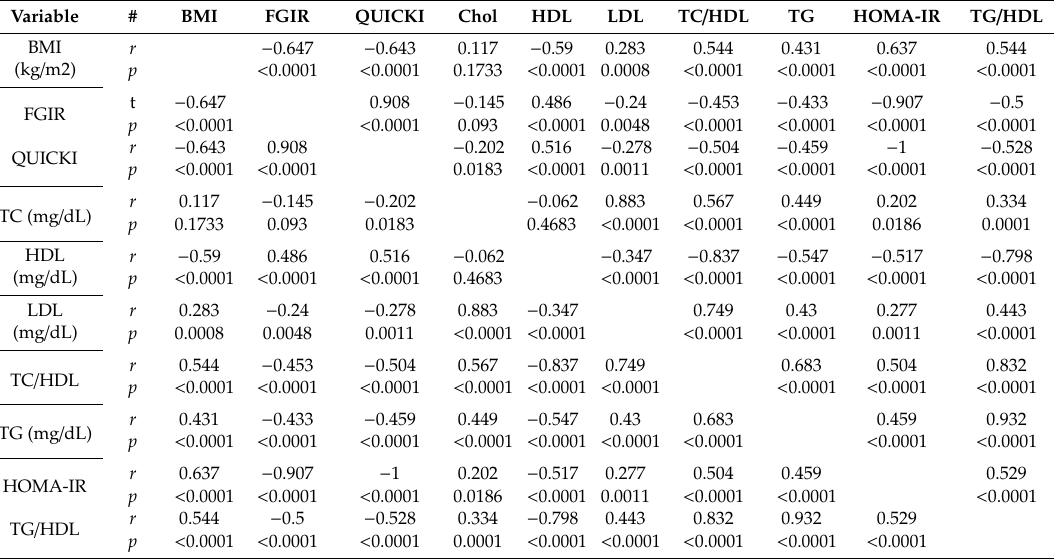
Table 6. Correlation between the studied parameters in Group